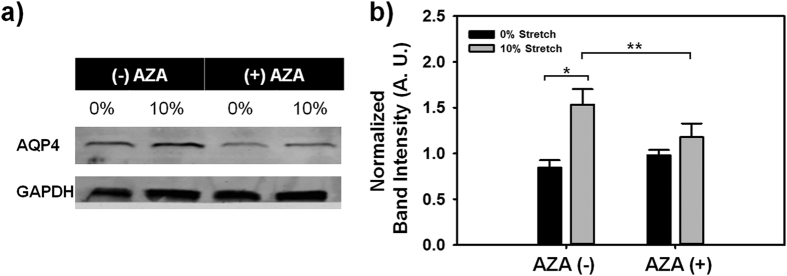
Western blotting analysis of AQP4 expression.(a) Representative western blot scans of AQP4 protein expression with GAPDH as control. (b) Semi-quantitative analysis of western blotting band intensity (*p < 0.001, **p = 0.051; n = 7).